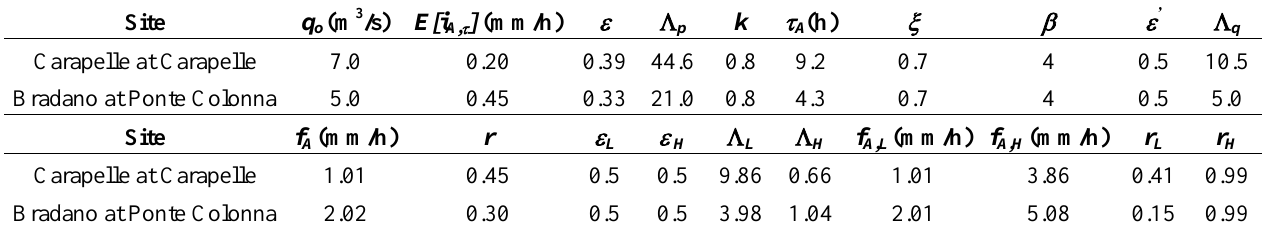
Table 2. Estimated parameter values of the IF and TCIF